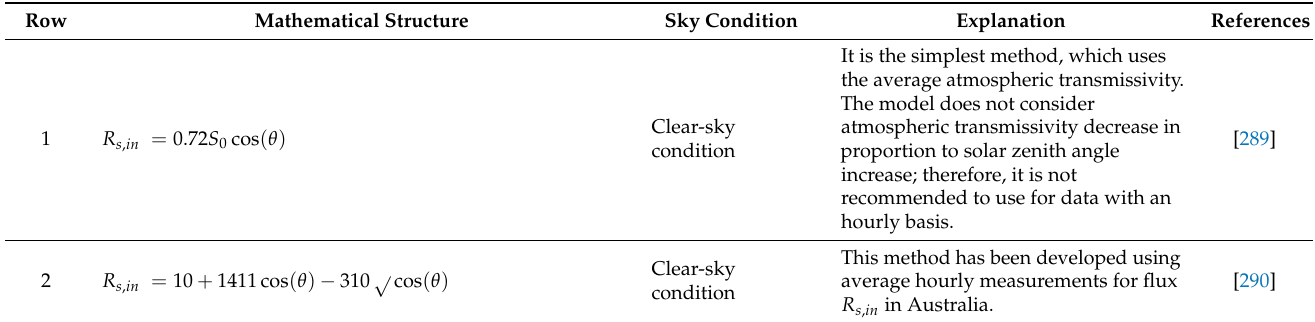
Table A1. Estimation models of R s , in under clear- and all-sky